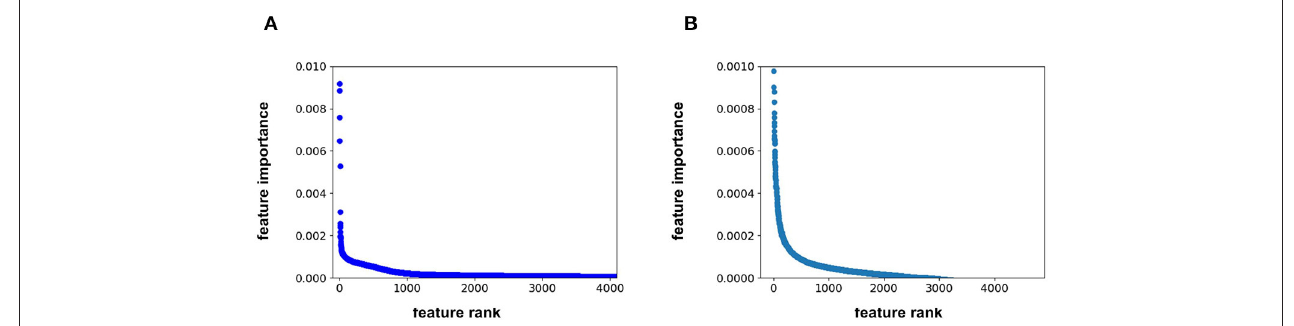
FIGURE 2 | (A) feature rank vs. feature importance for the (A) RF model and (B) FFN model. In (B) , the y-axis was capped at 0.001 to maintain resolution.